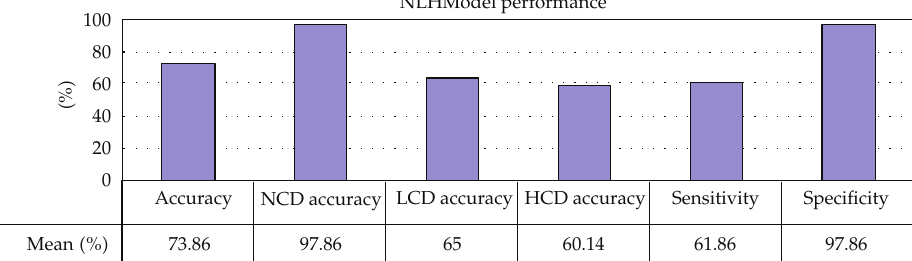
Figure 6: NLHModel predict